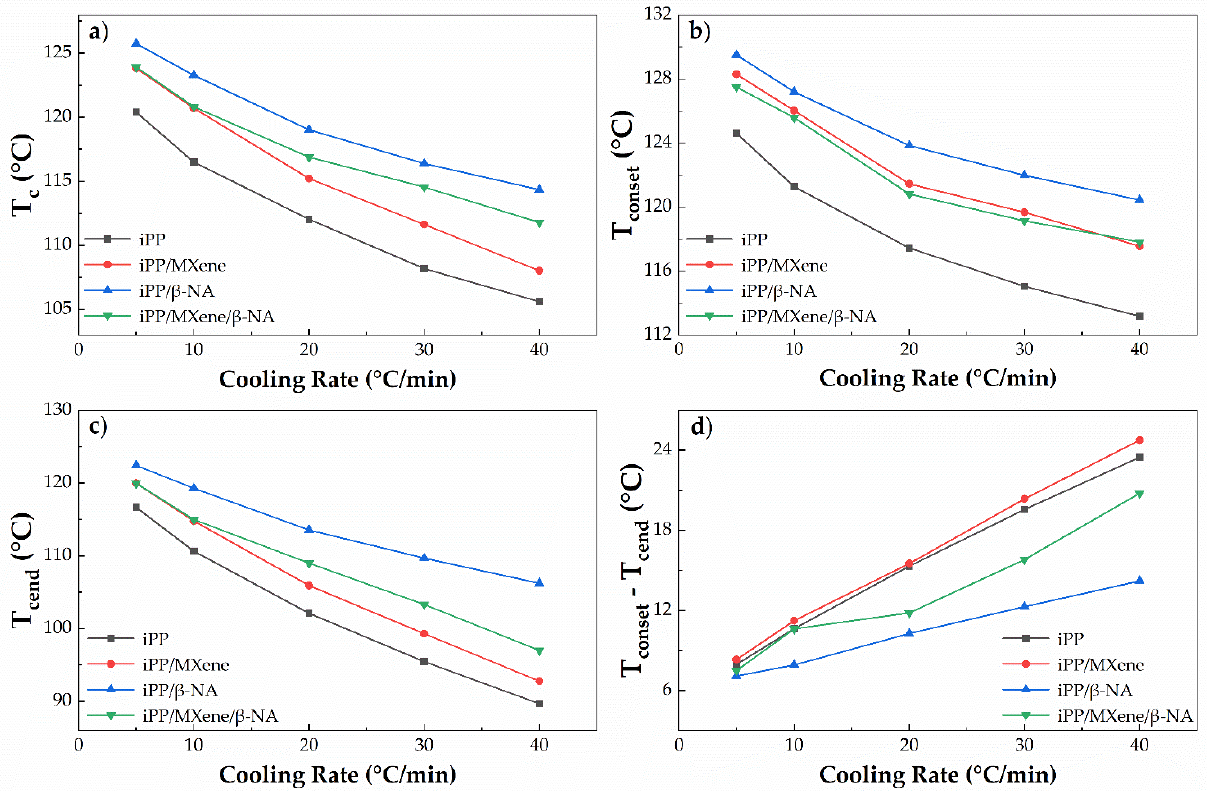
Figure 5. Plots of ( a ) T c , ( b ) T conset , ( c ) T cend , and ( d ) T conset —T cend of four samples as a function of cooling rate at T end = 50 °C.